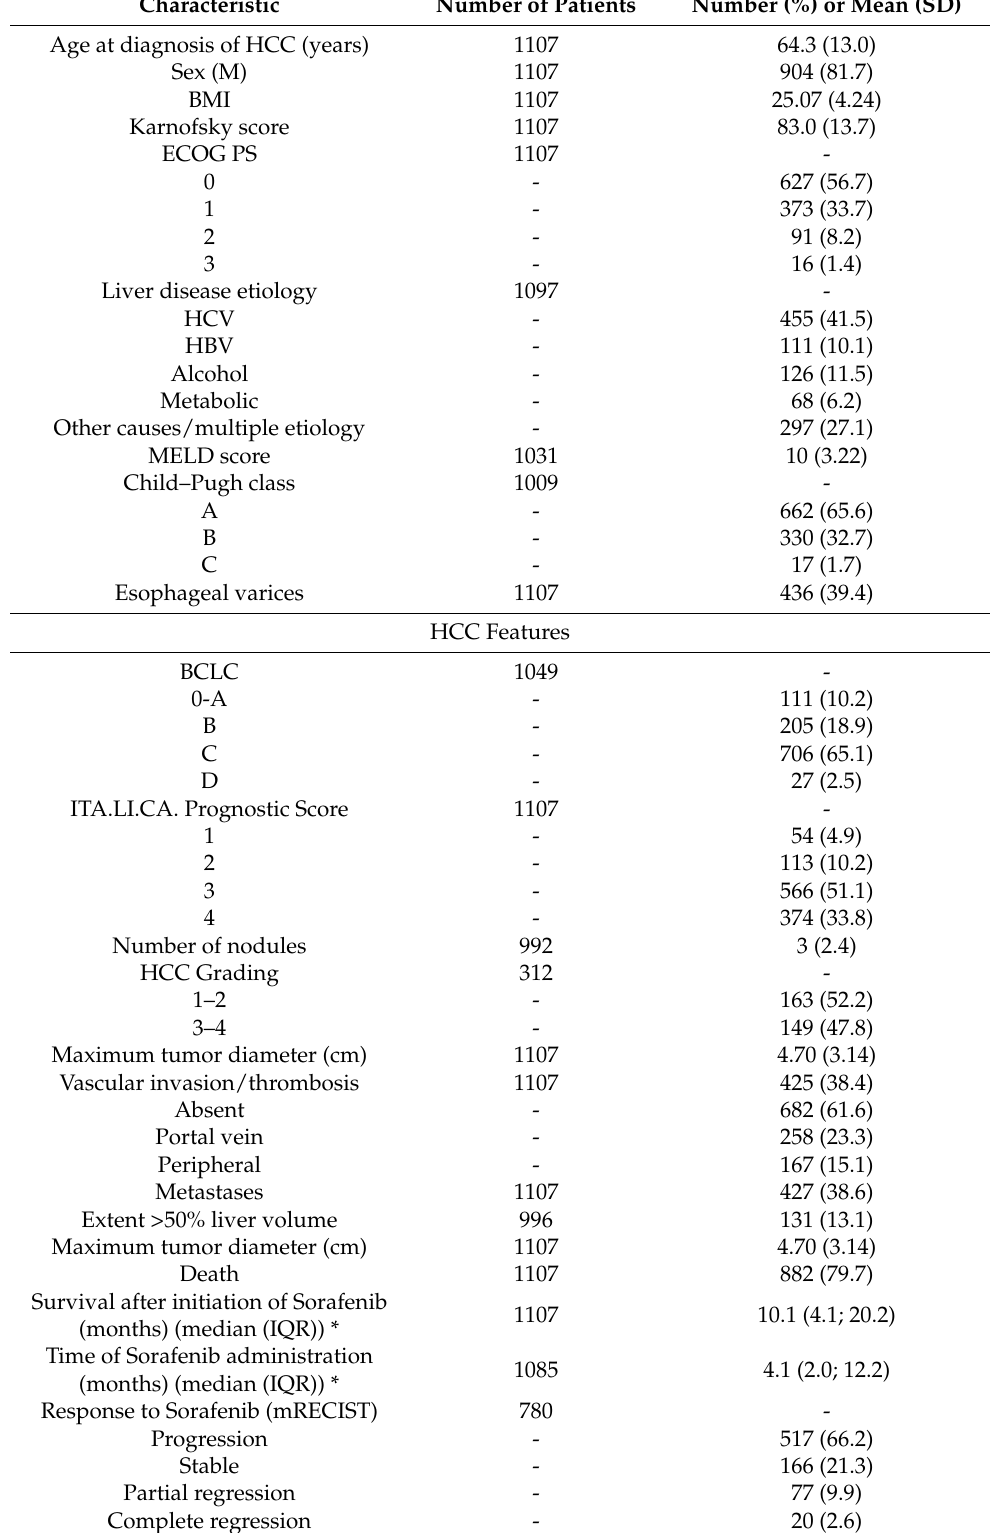
Table 1. Demographic, laboratory and clinical characteristics of the 1107 patients included in the